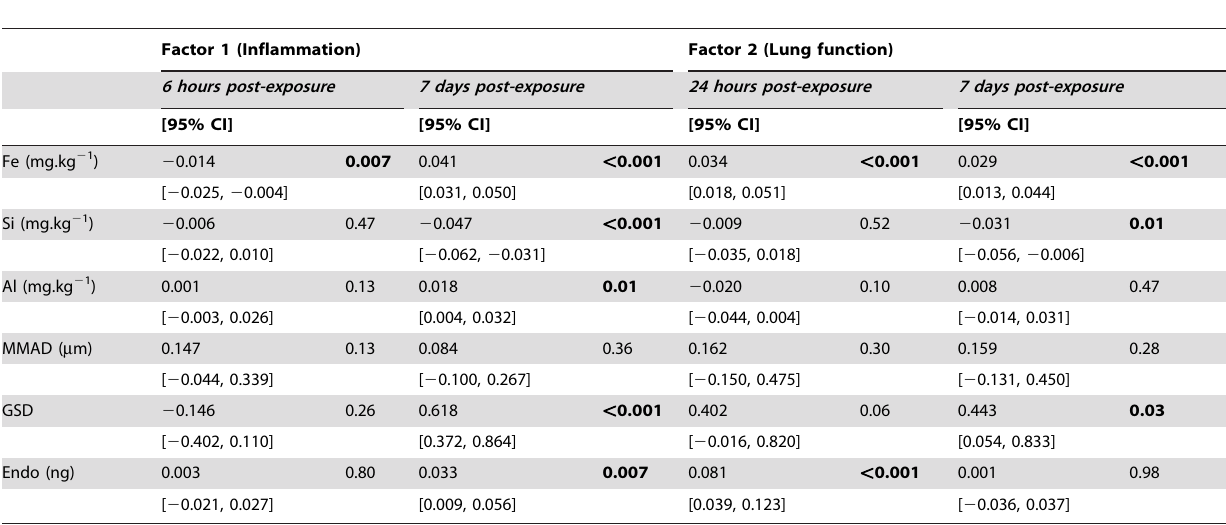
Table 5. Results of the multi-variate linear regression analysis examining the association between the physico-chemical characteristics of the geogenic PM 10 and the primary lung responses identified in the factor analysis.